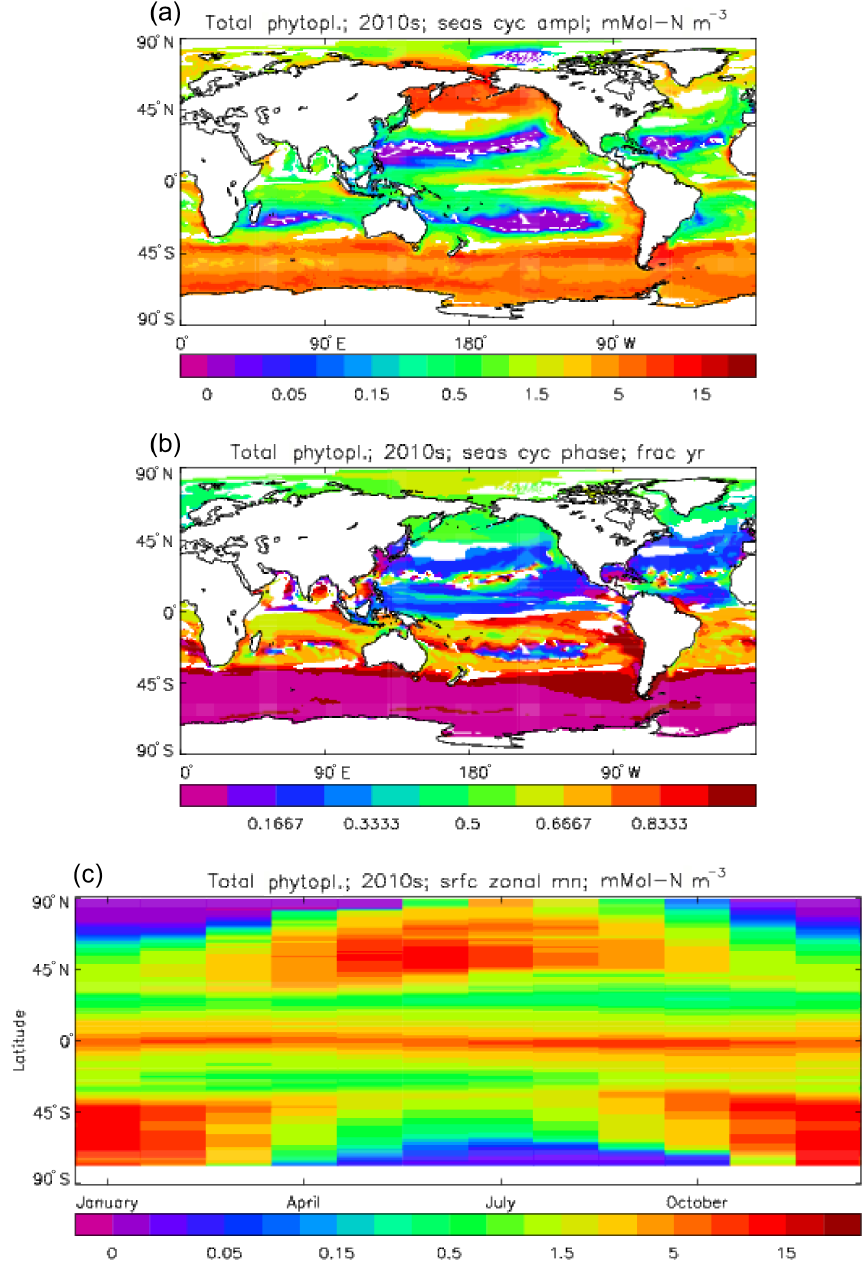
Figure 7. Total phytoplankton surface biomass mean seasonal cycle, averaged over the model years 2010 to 2019. (a) Amplitude (mMolNm − 3 ) and (b) phase (fraction of year when peak value occurs) of the seasonal cycle, determined by the best-fitting sine curve (only points for which the residual variance is less than half that of the original cycle are shown). (c) The global zonal mean for each month (mMolNm − 3